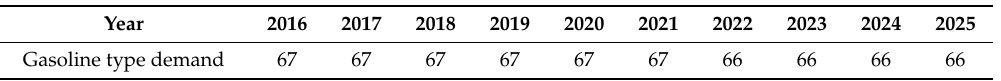
Table 9. Romania’s demanded fuel type gasoline (thousand TJ). Source: authors’ own calculation based on